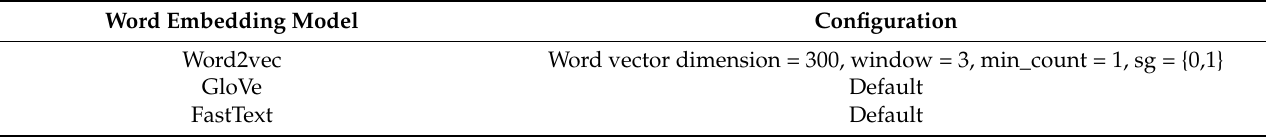
Table 3. Configuration of the used Word Embedding.